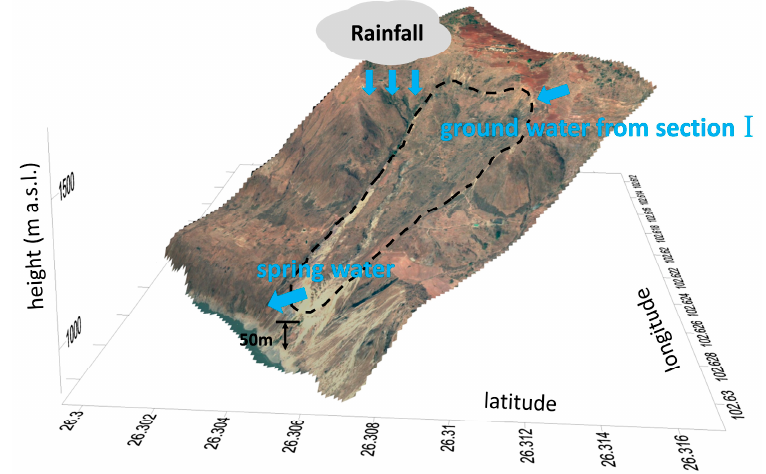
Figure 14. The diagram of the underground water supplement and discharge for Section II of Jinpingzi landslide.